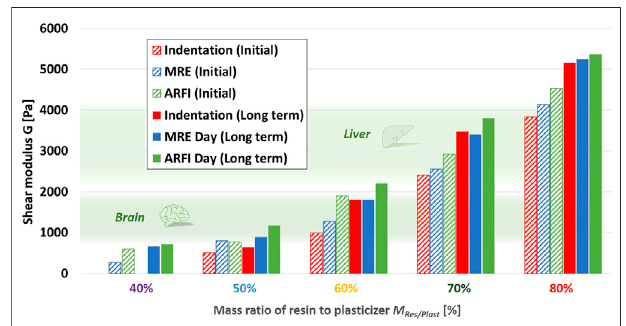
FIGURE 4 | Stiffness values measured directly ( “ Initial ” ) and 43 days ( “ Long term ” ) following the gelation-fusion process with MRE, ARFI and indentationtesting.Stiffnessrangesforliver[64]andbrain[59 – 63]foundinthe literature are represented for